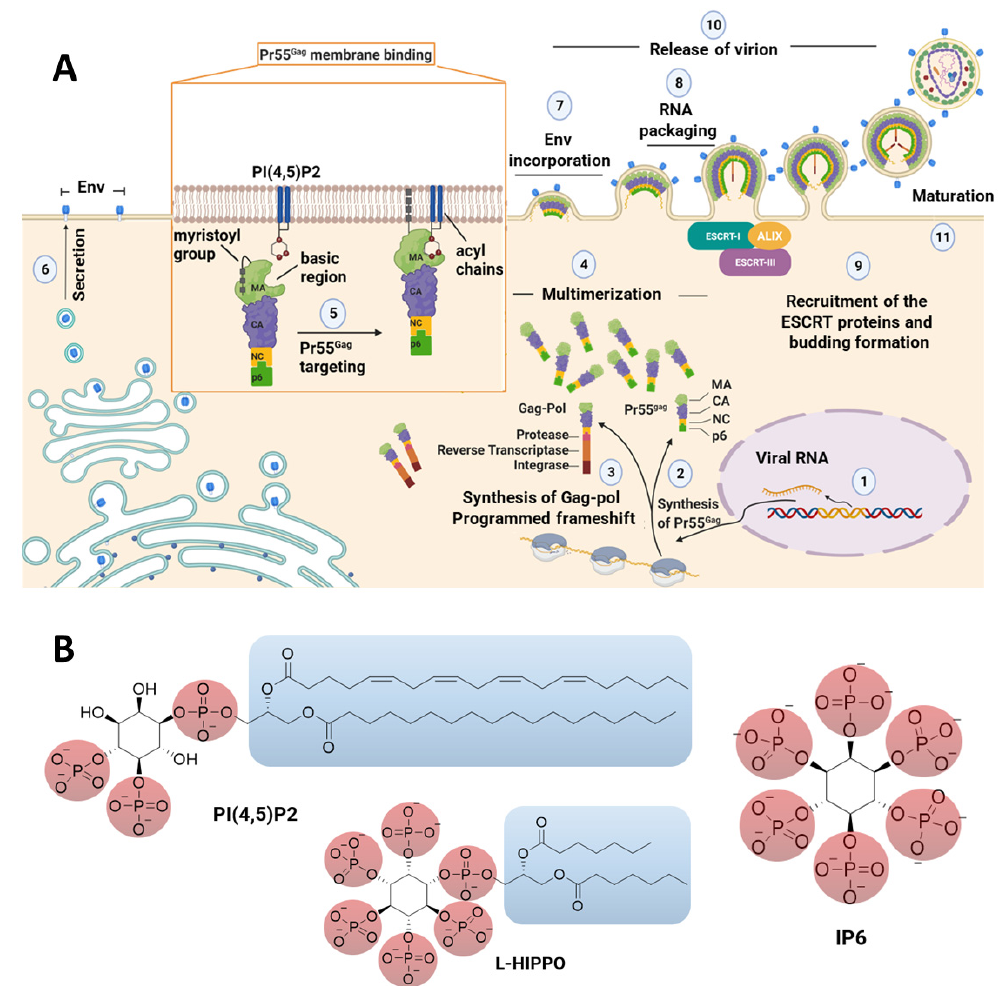
Figure 1. ( A ) Representation of the late stage of the HIV ‐ 1 cycle and interactions of the MA domain with PI(4,5)P2 in the membrane. ( B ) The chemical structures of PI(4,5)P2, IP6, and L-HIPPO. ALIX: ALG2-interacting protein X, CA: capsid domain, Env: viral envelope glycoprotein, ESCRT: endosomal sorting complex required for transport, MA: matrix domain, NC: nucleocapsid domain.